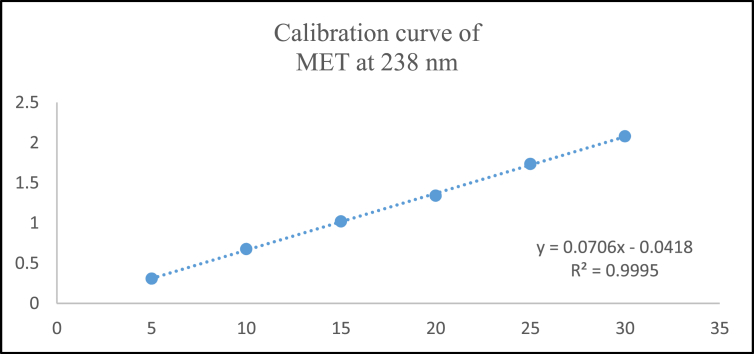
Calibration curve of MET at 238 λ1 = nm.